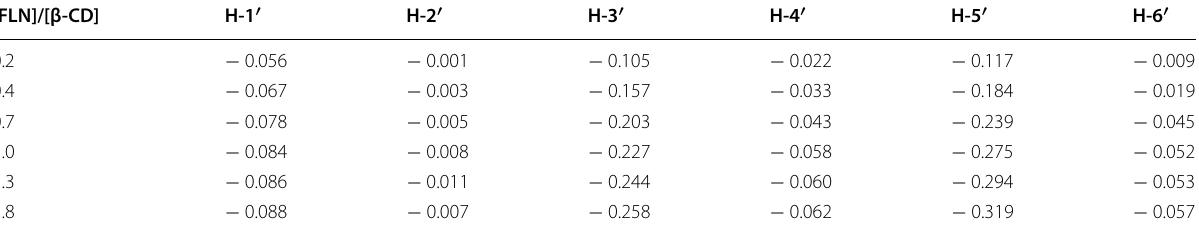
Negative values indicate upfield shift